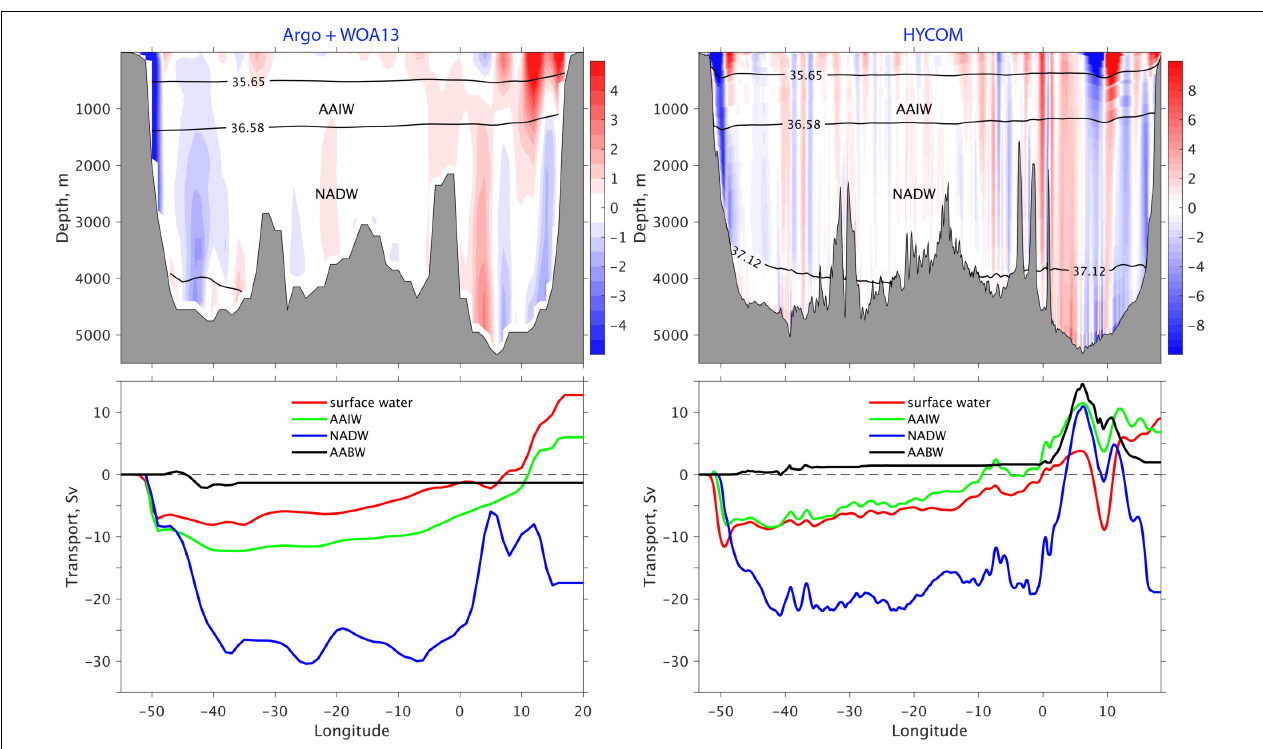
FIGURE 4 | Observed and modeled time mean meridional velocity (color shading in cm/s) across 34 ◦ S and the corresponding volume transport for the four density layers: near surface water ( σ 2 < 35.65 kg m − 3 ), Antarctic Intermediate Water (AAIW, 35.65 < σ 2 < 36.58), North Atlantic Deep Water (NADW, 36.58 < σ 2 < 37.12), and Antarctic Bottom Water (AABW, σ 2 > 37.12). Observations are based on a combination of Argo-WOA13 profiles; model results based on the global 1/12 ◦ HYCOM